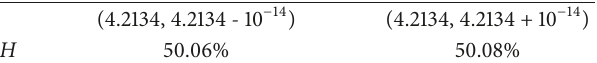
Table 6: The difference between generated binary sequences with different 𝑦 0 .